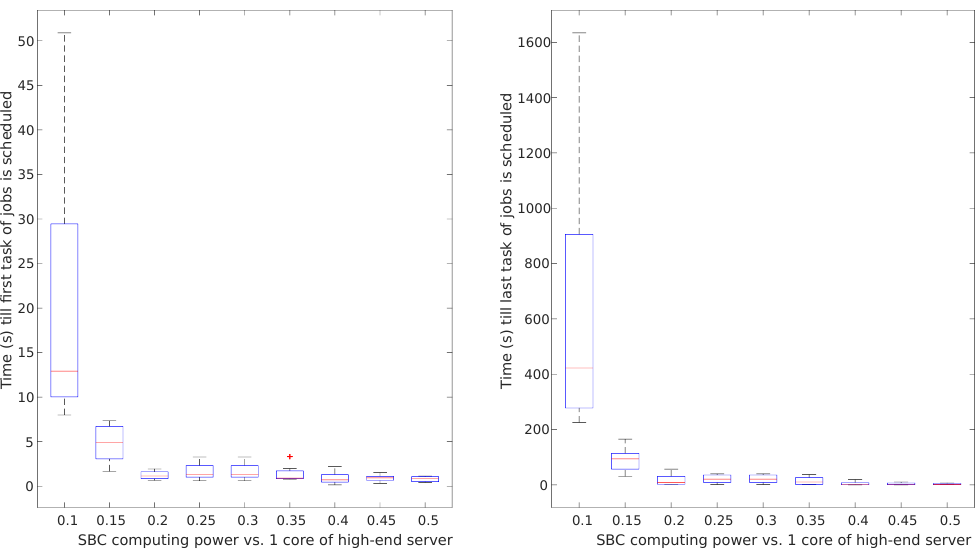
Figure 14. SBC computing power impact on queue times in distributed cloudlet computing SBC